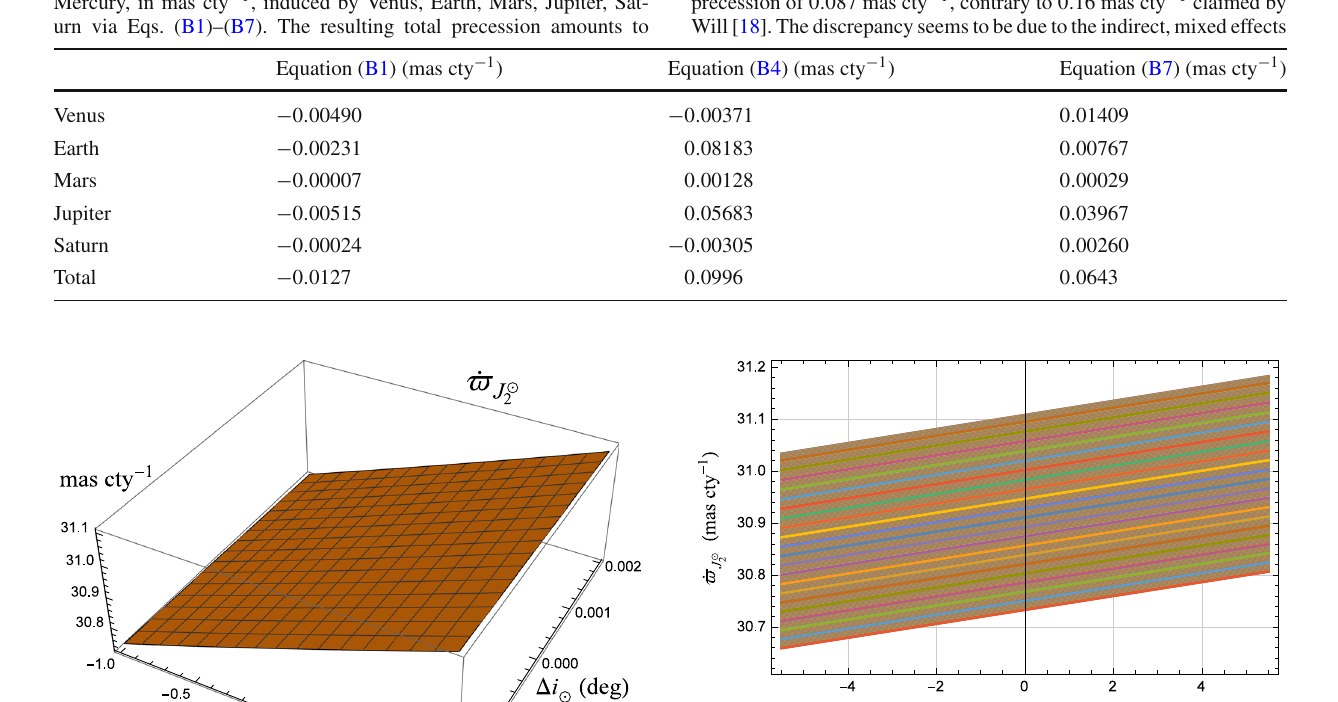
0 . 15 mas cty − 1 ; in particular, Eqs. (B1)–(B4) yield a combined overall